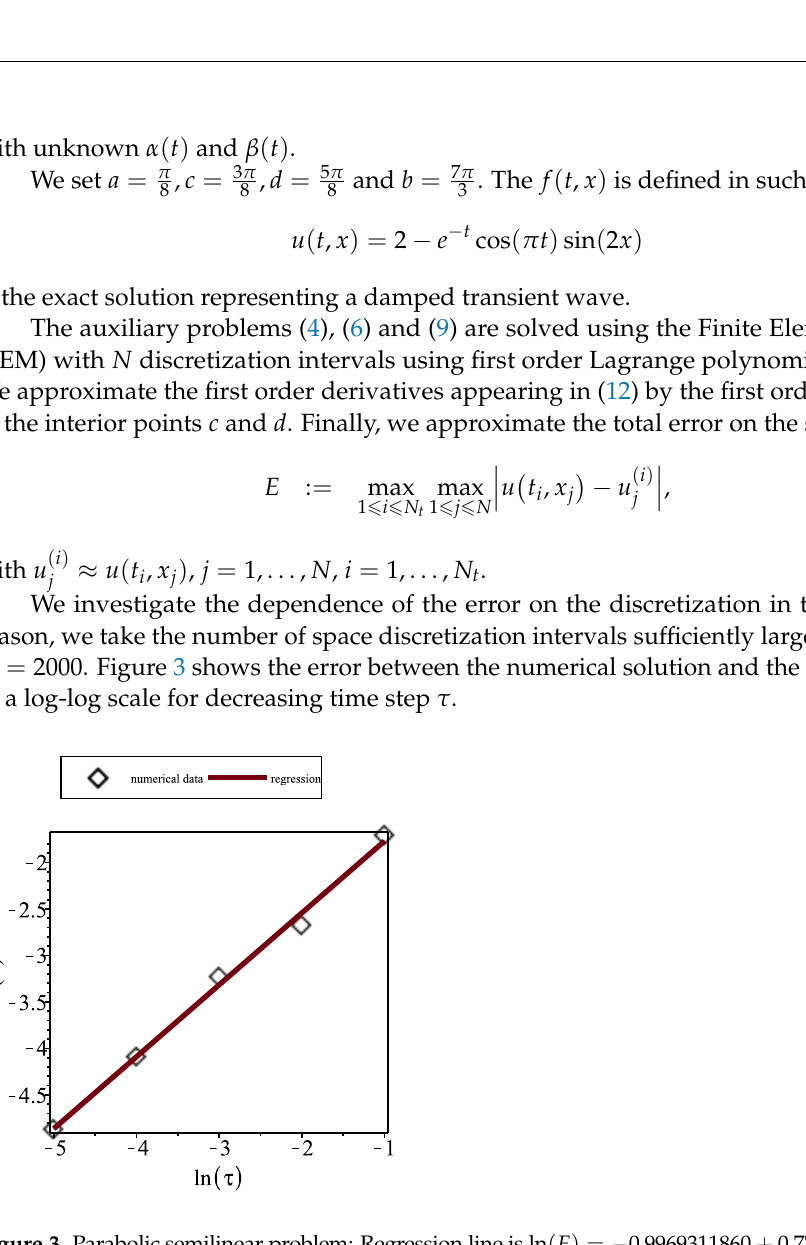
Figure 3. Parabolic semilinear problem: Regression line is ln ( E ) = − 0.9969311860 + 0.7733782860 ln ( τ ) with τ = T N t